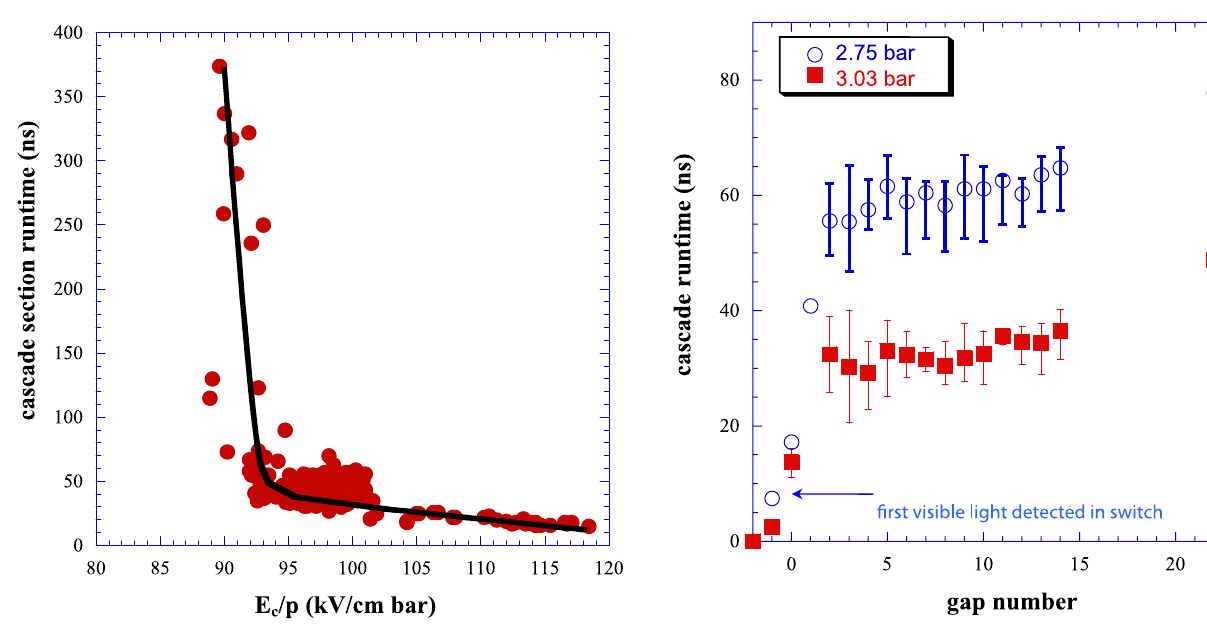
FIG. 23. (Color) Cascade breakdown times for four shots aver- aged each at 42 psia and 46 psia. The voltage for the 42 psia shots was (cid:1) 5 : 25 MV and (cid:1) 5 : 35 MV for the 46 psia shots. Gap 0 signifies the time at which the trigger gap capacitive discharge is detected. The time between gap 0 closure and gap 1 is the runtime of the first gap. The error bars represent the spread in the data for those four shots. The first 14 gaps nearest the trigger section are visible, the others are obstructed from the field